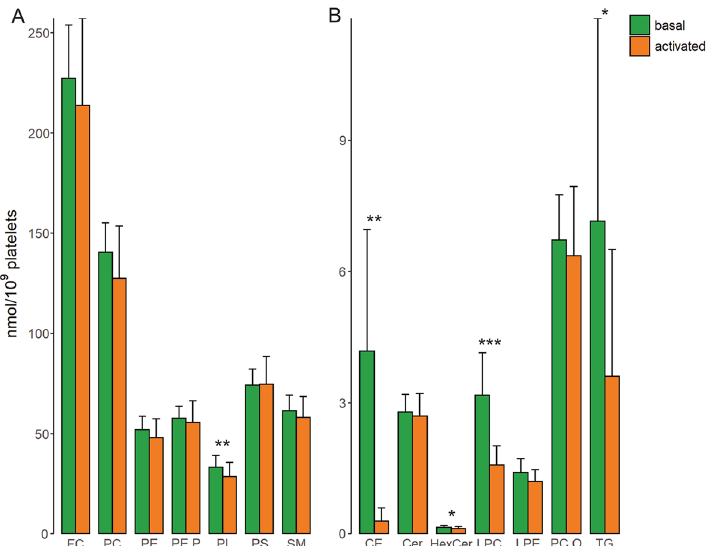
Figure 2. Lipid class concentrations of platelets. Displayed are sum concentrations of lipid classes of unstimulated (basal) and activated platelets upon thrombin stimulation for major ( A ) and minor ( B ) lipid classes. Mean and SD of 12 healthy human donors. *p < 0.05, **p < 0.01, ***p <